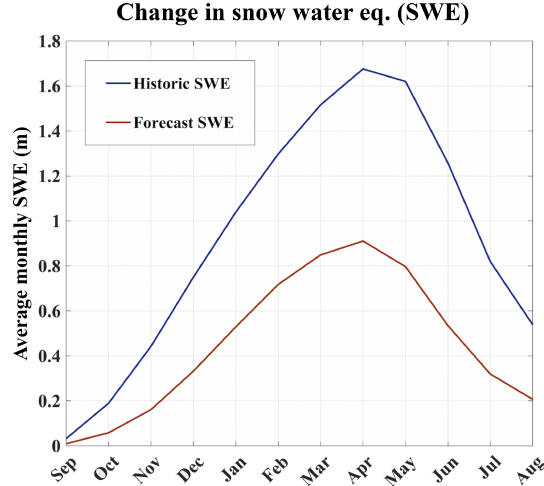
Figure 6. Monthly snow water equivalence (m) averaged for the entire GBNPP domain for both the historical (1979–2015) and pro- jection scenario (RCP 8.5;